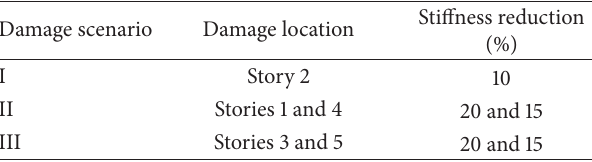
Table 2: The considered damage scenarios in the five-story shear frame.